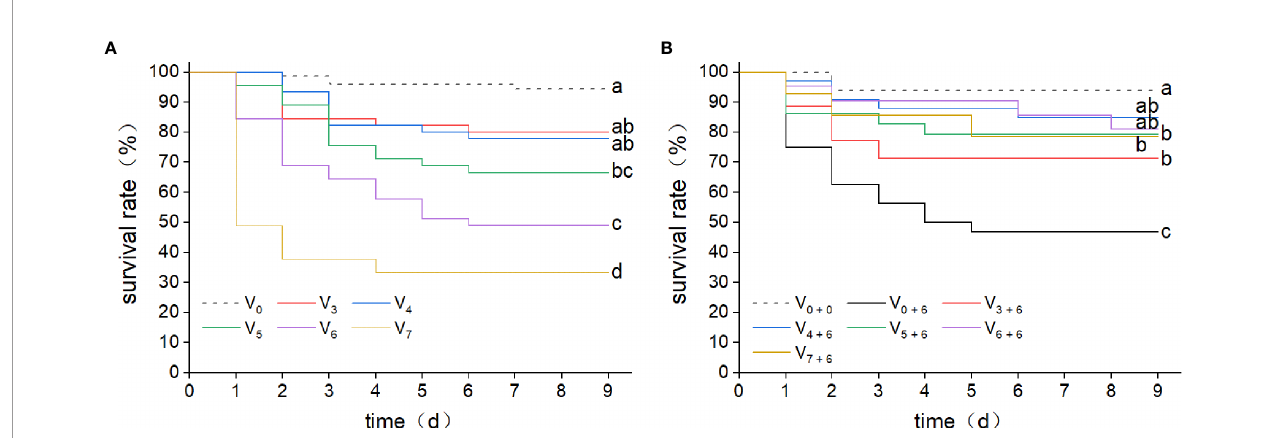
FIGURE 2 | Kaplan-Meier survival curves for abalone after two consecutive infections with V. harveyi . (A) Kaplan-Meier survival curves were generated from abalone following a fi rst injection with V. harveyi at concentrations of either 1.42 × 10 3 CFU mL -1 (V 3 ), 1.42 × 10 4 CFU mL -1 (V 4 ), 1.42 × 10 5 CFU mL -1 (V 5 ), 1.42 × 10 6 CFU mL -1 (V 6 ) or 1.42 × 10 7 CFU mL -1 (V 7 ), or with SSW as control (V 0 ). A total of 360 abalone were used in each group (120 per tank). Mortalities were monitored for nine days after infection. Different letter labels next to the graph lines indicate statistically signi fi cant differences among treatments ( p < 0.05, log-rank test, n = 360). (B) Kaplan-Meier survival curves were generated from abalone primed by injection with V. harveyi at fi ve different concentrations, or with SSW, followed by a second injection with V. harveyi at 1.58 × 10 6 CFU mL -1 (V 3 + 6 , V 4 + 6 , V 5 + 6 , V 6 + 6 V 7 + 6 and V 0 + 6 ) or with a second SSW injection as control (V 0 + 0 ). A total of 90 abalone were used in each group (30 per tank). Mortalities were monitored for nine days after infection. Different letter labels next to the graph lines indicate statistically signi fi cant differences among treatments ( p < 0.05, log-rank test, n =